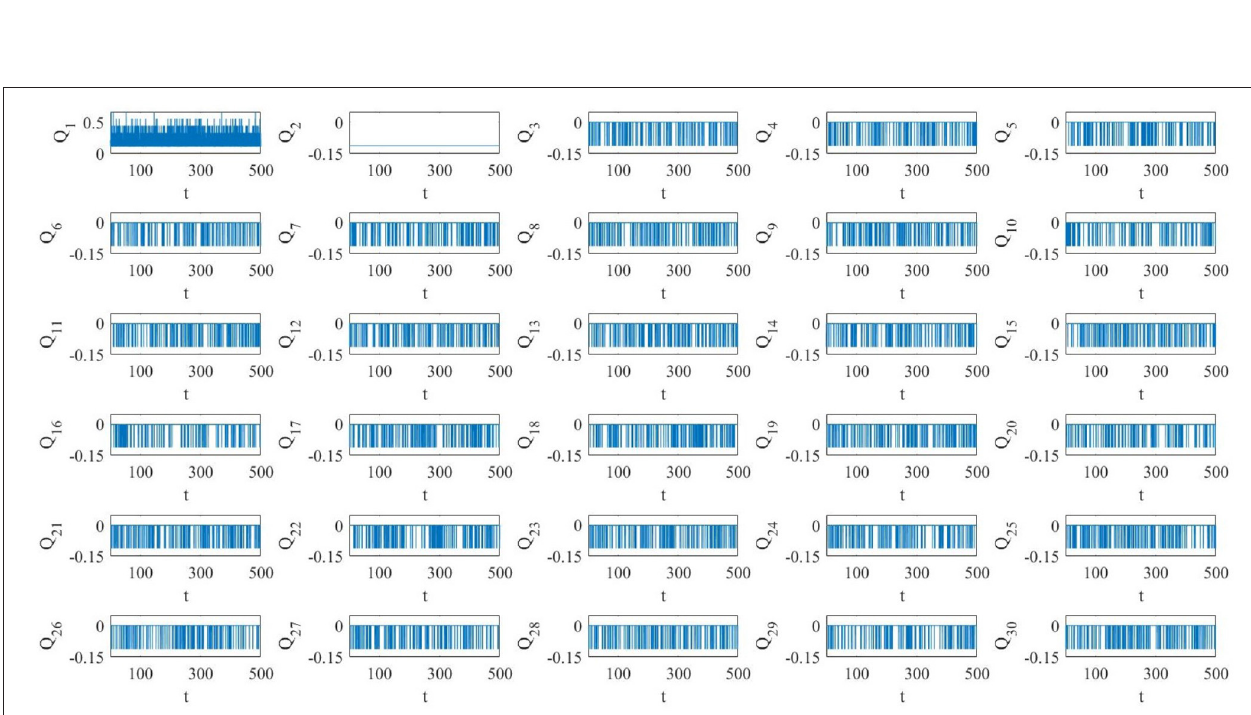
FIGURE 9 | Components Q i ( i = 1, ... ,30) of Q [ w c ( t )] as function of time for the blinking network under study. At each blink, new non-local links are added and the whole network possibly changes of manifold.